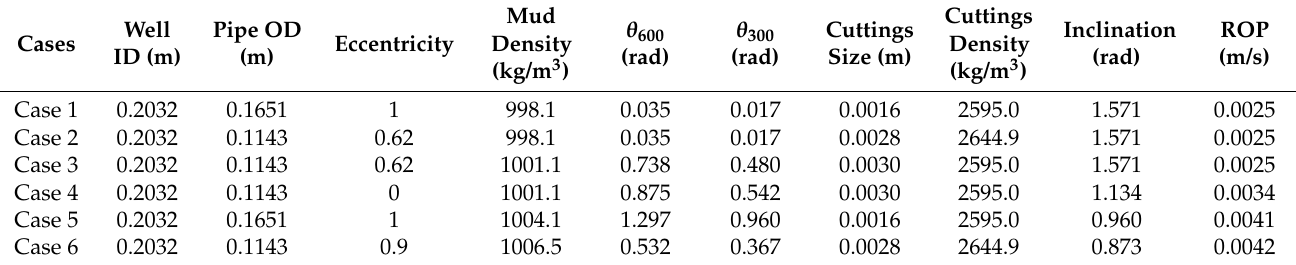
Table 3. Cases considered for the analysis in this